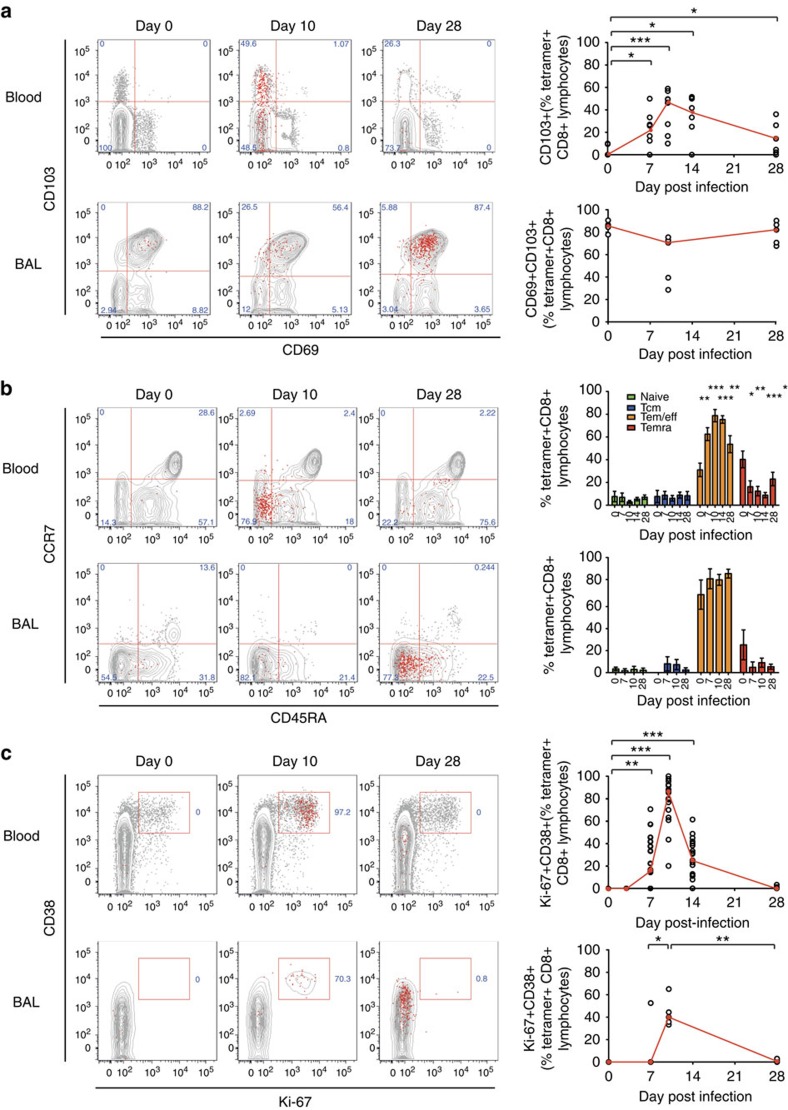
RSV-specific CD8+ T cells in BAL display a distinctive resident memory phenotype.Tetramer+ CD8+ T cells in blood and BAL were co-stained for markers to assess their differentiation status. (a) CD69 and CD103 as canonical markers of resident memory CD8+ T cells are shown in blood (n=9) and BAL (n=5) from infected volunteers. Significant P values for two-tailed Wilcoxon matched pairs tests in blood compared with baseline are shown (day 7, P=0.0313; day 10, P=0.0039; day 14, P=0.0313; and day 28, P=0.0313). (b) Memory markers CD45RA and CCR7 are shown in blood (n=19) and BAL (n=8). Mean±significant P values for two-tailed Wilcoxon matched pairs tests compared with baseline are shown in blood for T-effector/effector memory cells (day 7, P=0.0034; day 10, P=0.0002; day 14, P=0.0002; day 28, P=0.0067) and effector memory T cells re-expressing CD45RA (day 7, P=0.0443; day 10, P=0.0025; day 14, P=0.0003; day 28, P=0.0135). (c) Proliferation and activation markers Ki-67 and CD38 are shown in blood (n=19) and BAL (n=8). Significant P values for two-tailed Wilcoxon matched pairs tests are shown compared with baseline in blood (day 7, P=0.0025; day 10, P=0.0001; and day 14, P=0.0005) and BAL (day 7 versus day 10, P=0.0444; and day 10 versus day 28, P=0.0022 as no Ki-67+CD38+ cells were found in any baseline samples). Throughout, representative plots from a single subject at day 0, 10 and 28 post infection are shown with tetramer+ cells as red dots and total CD8+ T cells in grey contours. Summarized data are shown for all RSV-infected subjects (who could be analysed using tetramers) with median frequencies shown in red. Abbreviated P values are shown: NS (not significant)=P>0.05, *P<0.05, **P<0.01.